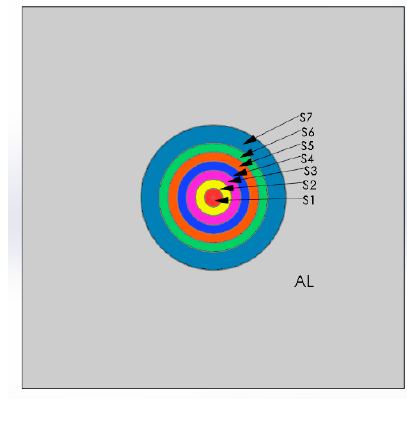
Figure 9. Excitation and loading area.